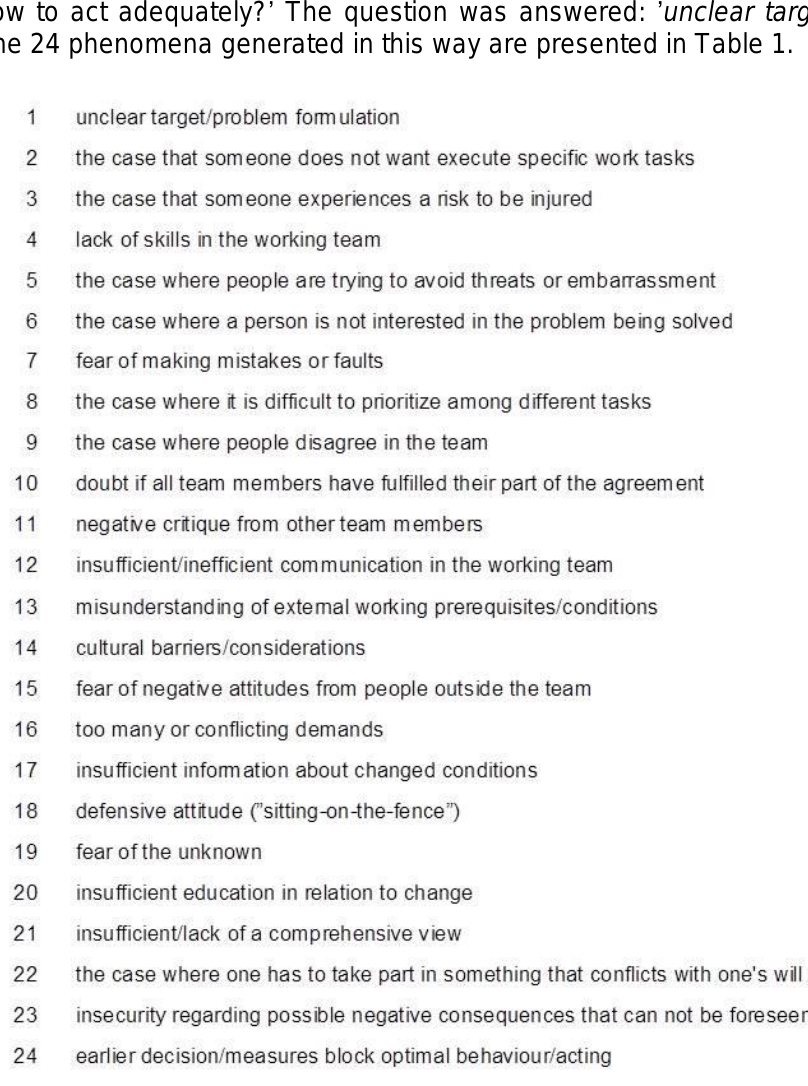
Table 1 The 24 phenomena, each representing a unique combination of the problem-solving situation and reasons why individuals do not act in an anticipated rational